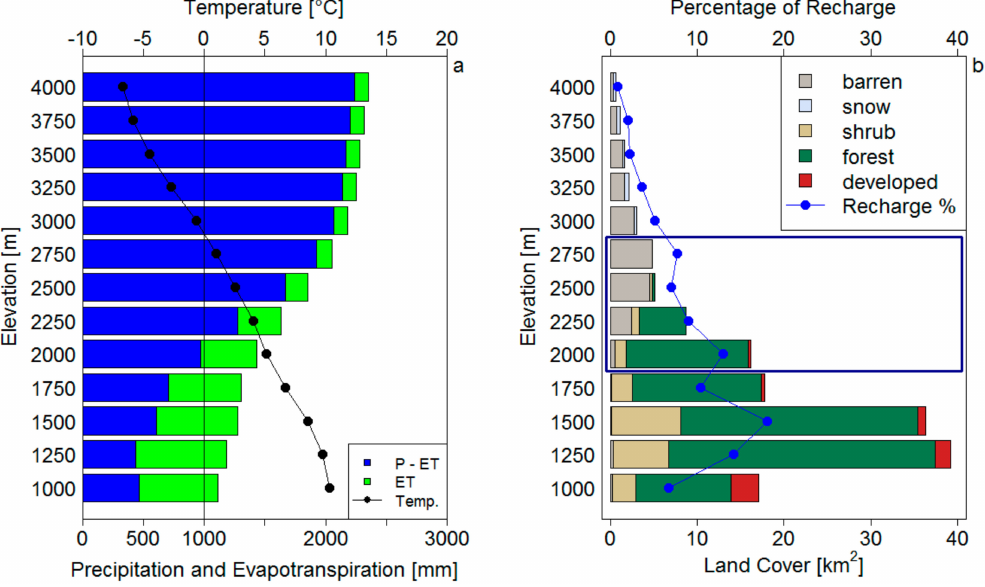
Figure 6. Mean annual precipitation and temperature for 250 m elevation bins within the 14-km radius in the southwest quadrant of Mt. Shasta ( a ). The blue bar represents recharge (precipitation minus evapotranspiration), the green bar represents evapotranspiration (ET), the sum being the total precipitation (P). Land cover on south west quadrant of Mt Shasta within a 14 km radius ( b ) and percentage of total recharge (=P − ET, blue) for each elevation bin. Dark blue box indicates elevation range of recharge derived from stable isotopes and noble